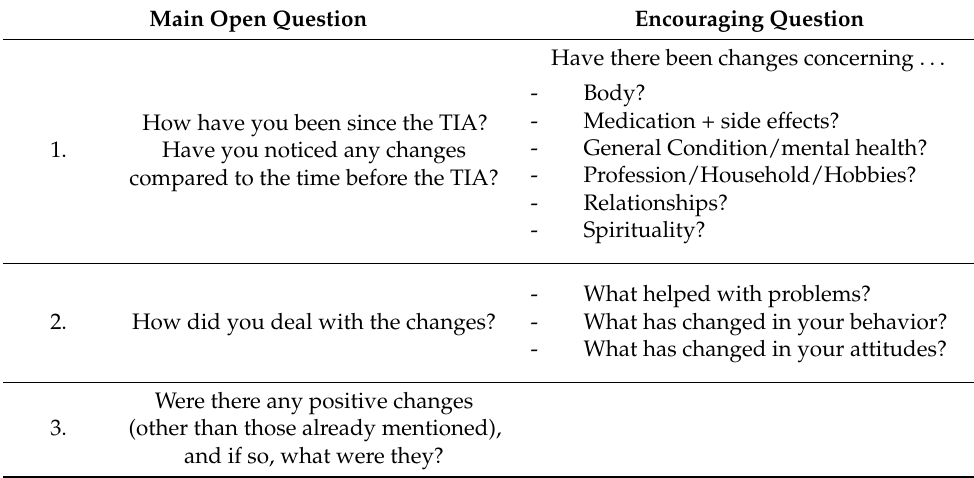
Table 1. Interview manual for the semistructured interview with TIA patients three months after